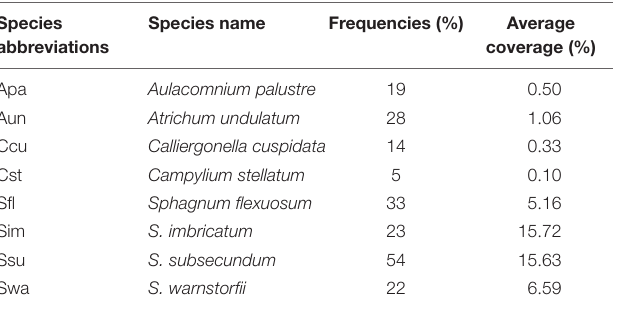
TABLE 1 | The frequencies and average coverage of bryophyte species in Jinchuan